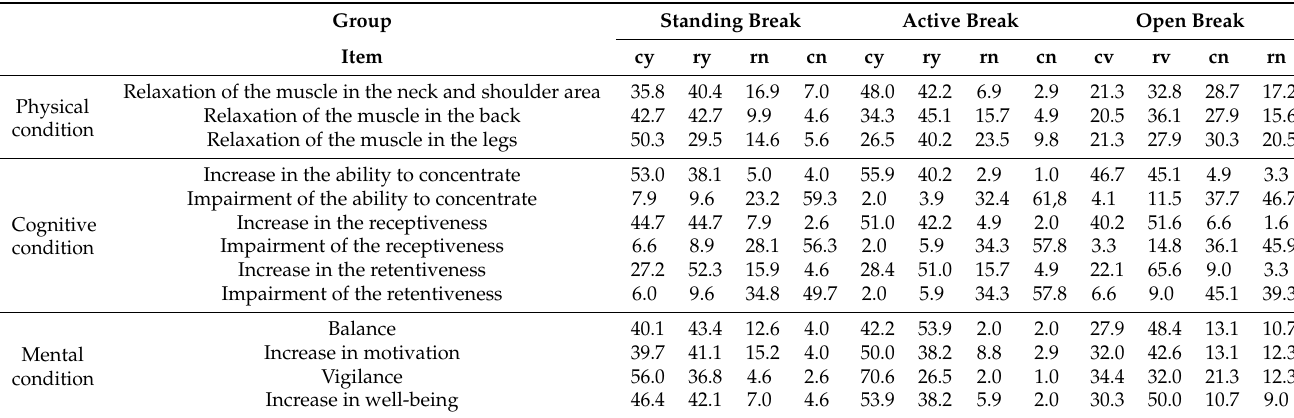
Table 5. Students’ subjective perception during the standing break, active break, or open break during the lectures at semester end in % (N =